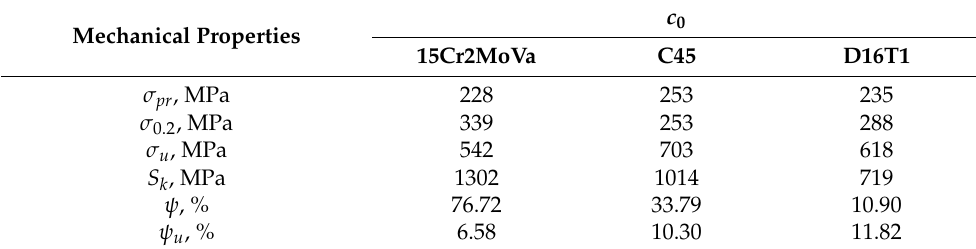
Table 5. Normalised mechanical